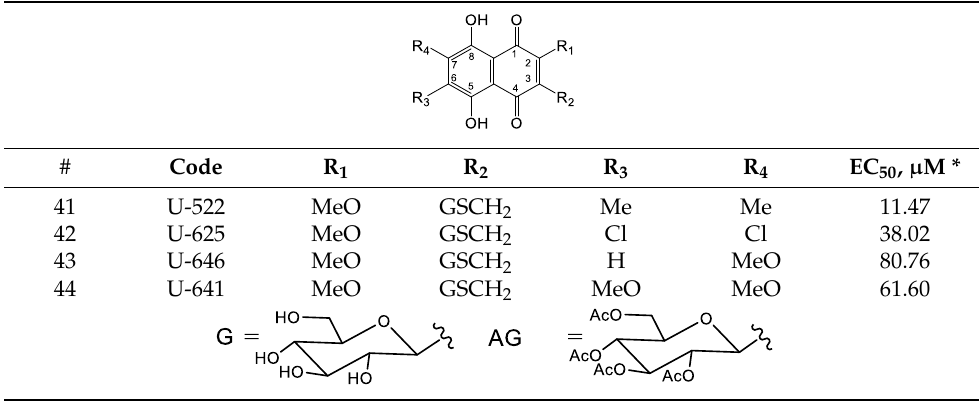
Table 1. Chemical structures of studied 5,8-dihydroxy-1,4-naphthoquinone